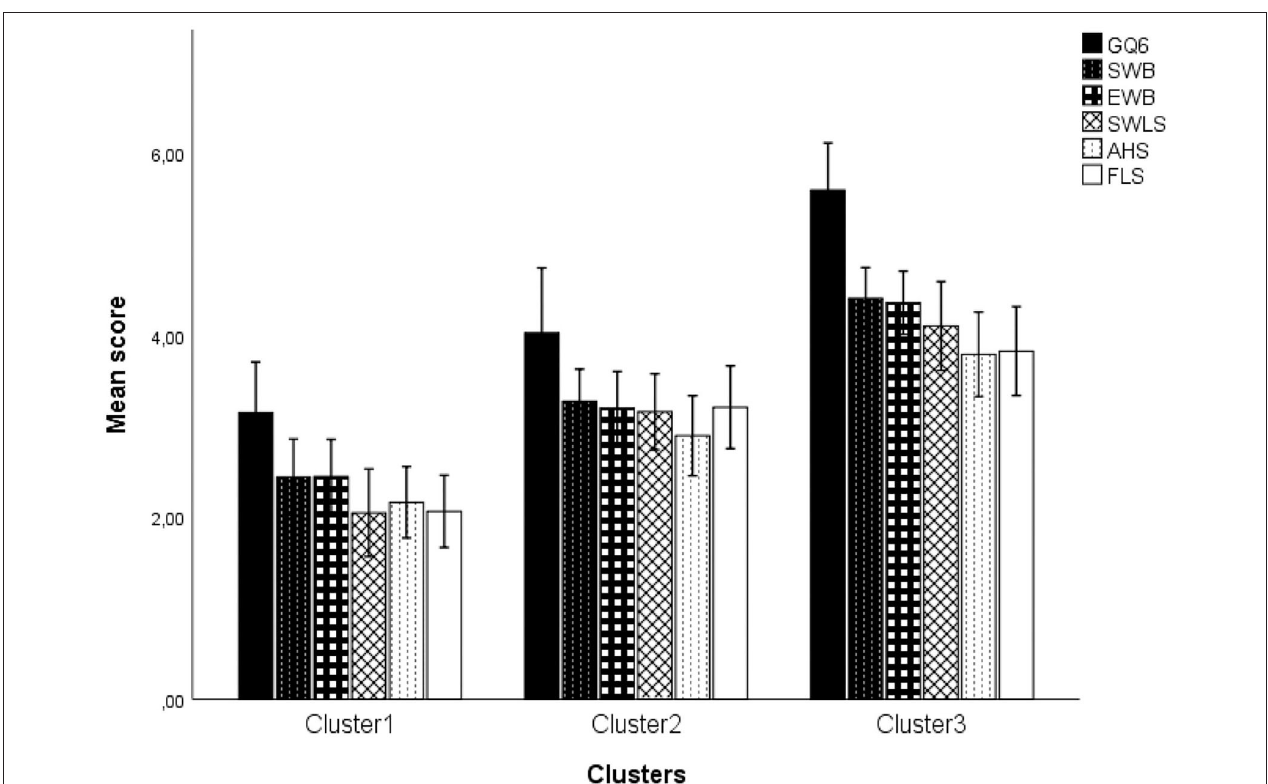
FIGURE 1 | Distribution of the mean scores of scales according to the